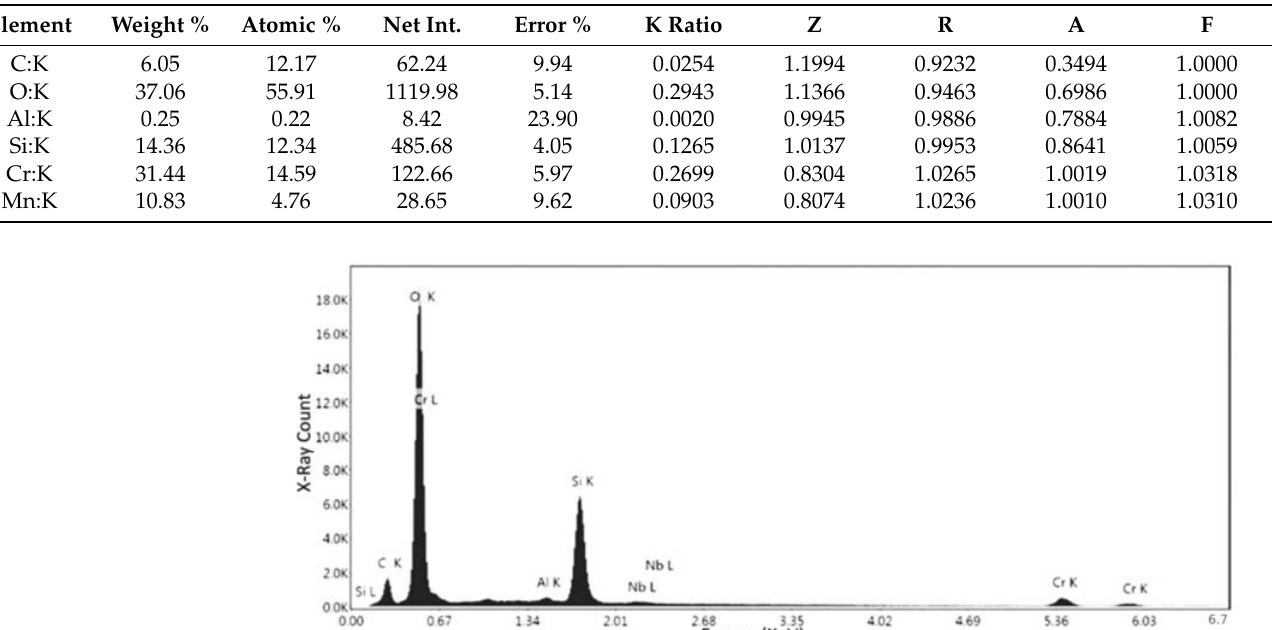
Table 5. Chemical composition as the result of EDS analysis in specimen No. 5 (first point).